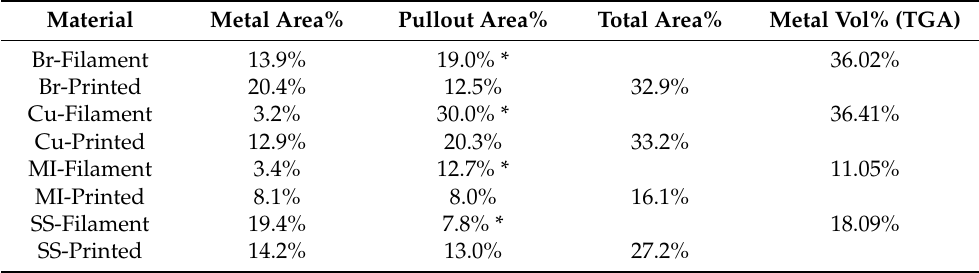
Table 3. Area % of total reinforcement observed in filament and printed micrographs. Pullout amounts in filament micrographs are estimated by subtracting the detected metallic particles from the total (metal + pullout) of their printed